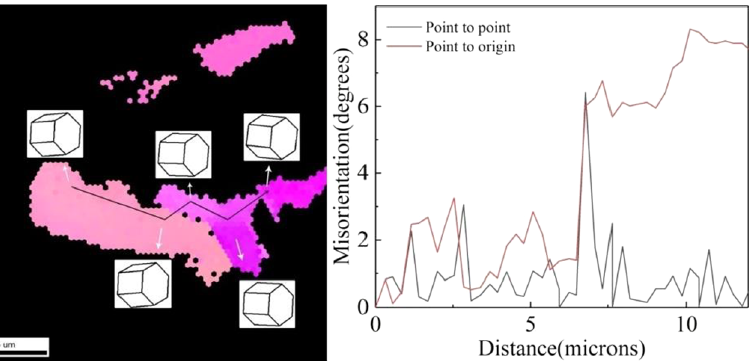
Figure 9: Inverse pole fi gure of the sample at the grain orientation of ( 10 − 12 ) after deformation, and the misorientation along the